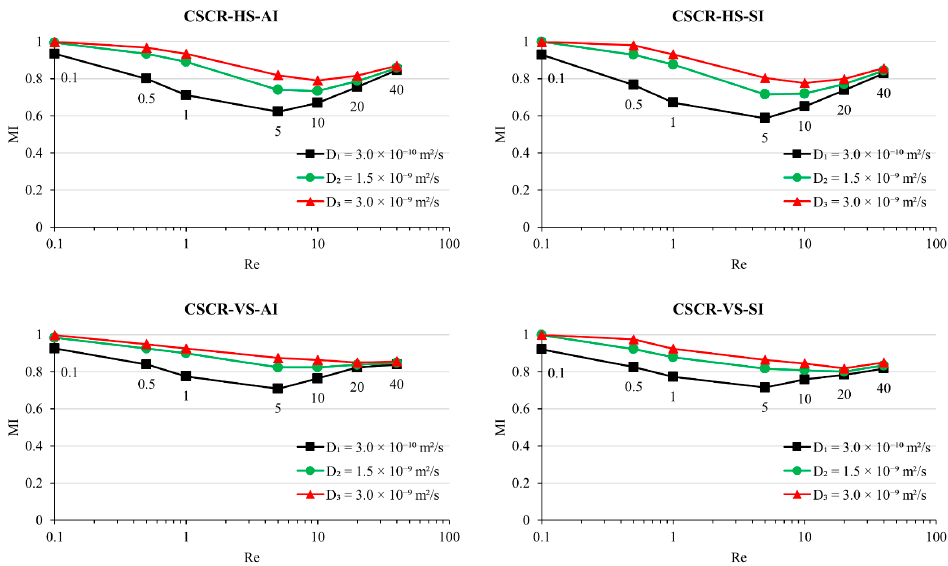
Figure 11. Mixing index vs. Re number for different inlet and injection configurations of the CSCR micromixer.